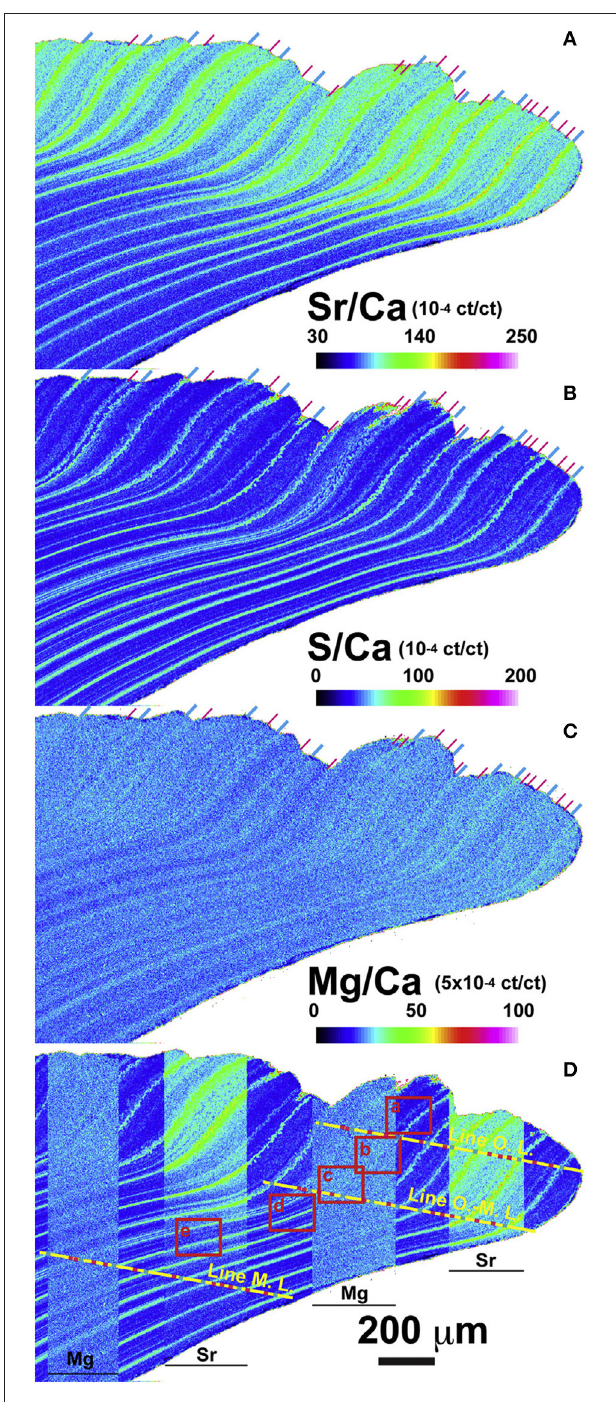
FIGURE 9 | Electron probe microanalyses (EPMA) showing the micrometer-scale distribution of (A) Sr/Ca, (B) S/Ca, (C) Mg/Ca in the shell of Arctica islandica . Signal intensity (cumulative count) ratio is illustrated as a map using a color scale (ct/ct: count/count) shown at lower right of each elemental map. (D) Sr/Ca and Mg/Ca maps are partly overlapped on S/Ca map for the comparison among each elemental map. Position of annual and sub-annual growth lines are clearly recognized and indicated by the blue and pink lines, respectively, at the top of shell signal images and on the yellow lines (Figure from Shirai et al.,